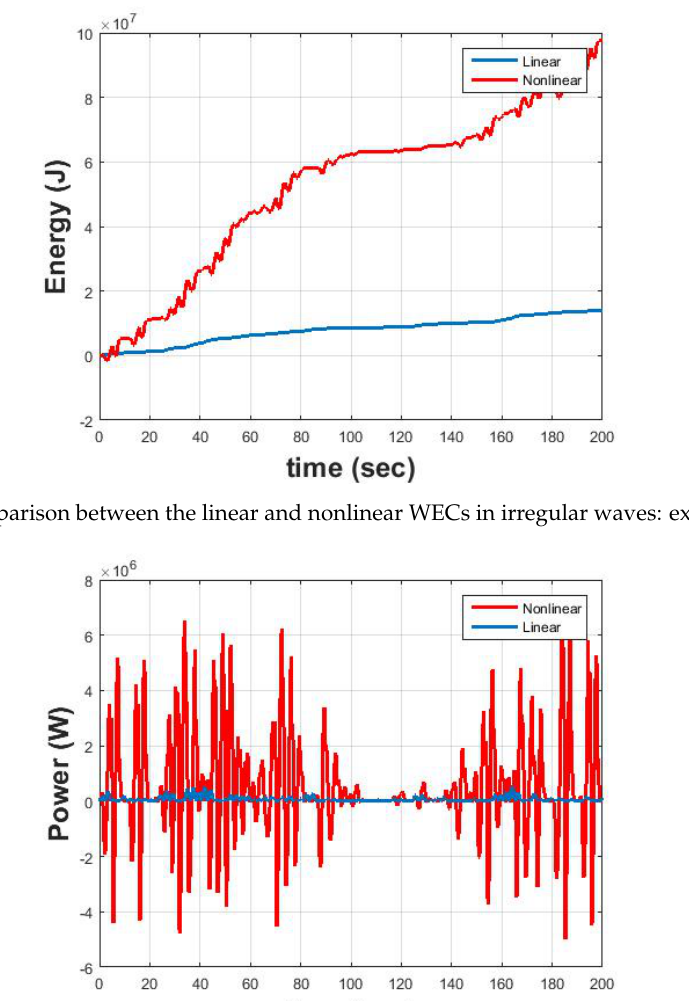
Figure 17. Comparison between the linear and nonlinear WECs in irregular waves: extracted